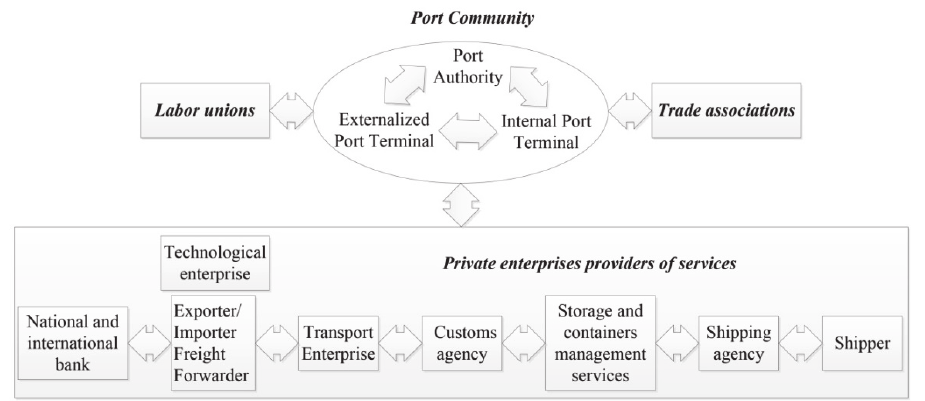
Fig. 1. Port private actors. Adapted (Durán & Córdova,